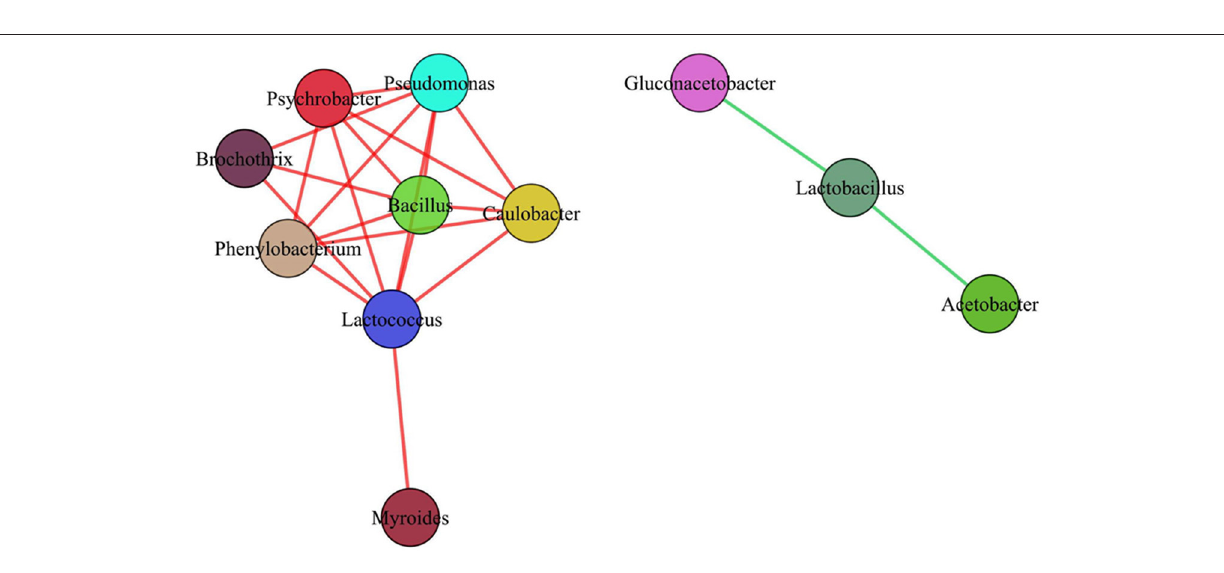
FIGURE 11 | Implications of the antagonistic or synergistic interactions between the microbial populations. Green lines represented the antagonistic relationship between the two microbial populations. Red lines represented the synergistic relationship between the two microbial